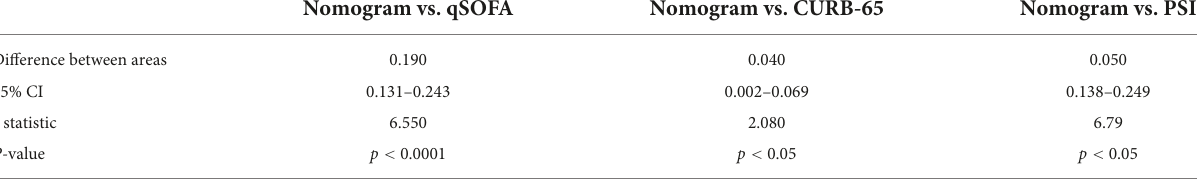
TABLE 5 Comparison of ROC for mortality in training cohort.